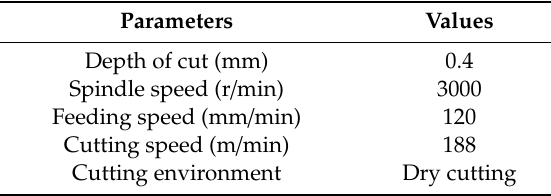
Figure 3. Turning experiments of gray cast iron. Table 3. Cutting parameters of cast